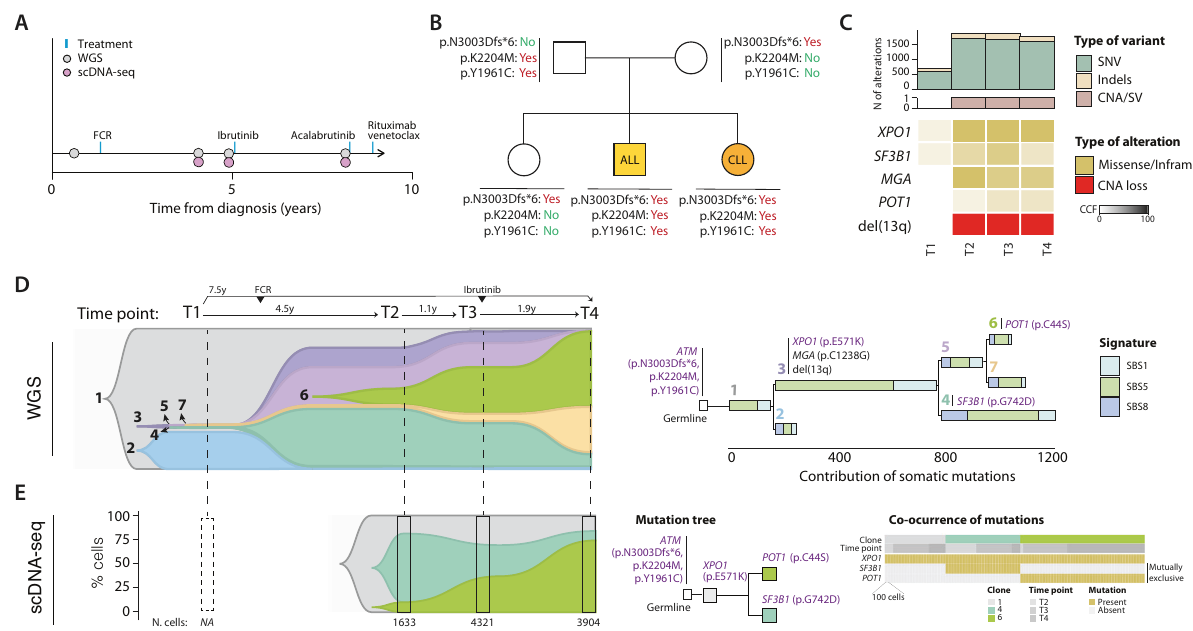
Fig. 1 Clinical course and genomic characterization. A Clinical course and samples analyzed. B Pedigree tree of germline variants in ATM . The two missense variants carried by the mother and the frameshift variant from the father were inherited by the chronic lymphocytic leukemia (CLL) case studied and her brother that developed acute lymphoblastic leukemia (ALL). C The upper barplots show the number of mutations [single nucleotide variants (SNV) and short insertions and deletions (indels)] and copy number alterations (CNA) or structural variants (SV) at each time point. The lower oncoprint shows the driver alterations, the transparency of the color is proportional to the cancer cell fraction (CCF). D The fi shplot [left] depicts the subclonal architecture and clonal dynamics inferred from WGS. Each vertical line represents a time point analyzed. Each subclone is painted in a different color, and its height is proportional to the CCF at each time point. The upper-right tree shows the phylogeny of the tumor cell subpopulations, the length of the branches is proportional to the number of acquired SNV, and they are colored by contribution of mutational signatures identi fi ed in CLL [right]. The clock-like signatures SBS1 and SBS5 contributed most of the mutations acquired. E The fi shplot (left) shows the clonal dynamics measured by single-cell analysis. For each available time point, the integrated barplot shows the proportion of cells harboring each speci fi c combination of alterations in the driver genes illustrated on the “ Mutation tree ” (middle). The total number of analyzed cells at each analyzed sample is shown at the bottom. The “ Co-occurrence of mutations ” plot (right) indicates the presence or absence of mutations in each cell. For illustrative purposes, cells have been merged in bins of disease: XPO1 (p.E571K), SF3B1 (p.G742D), MGA (p.C1238G), and POT1 (p.C44S). The mutations in XPO1 and SF3B1 were already present at